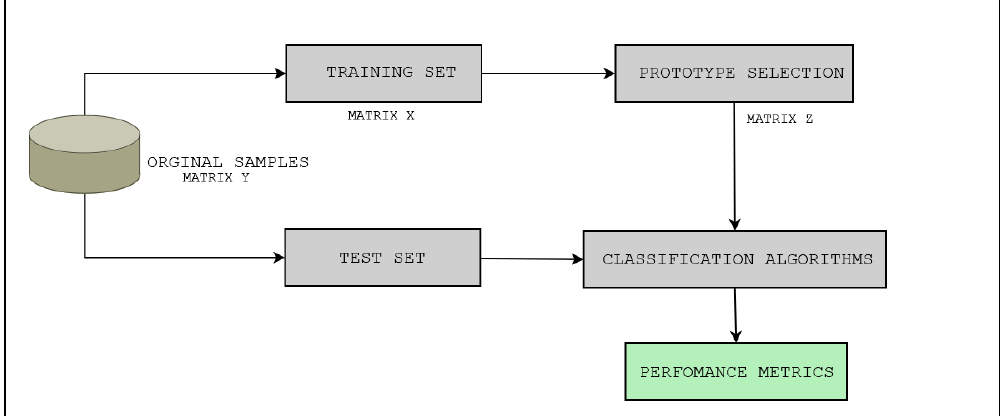
Figure 4. Data analysis scheme including prototype selection and classification